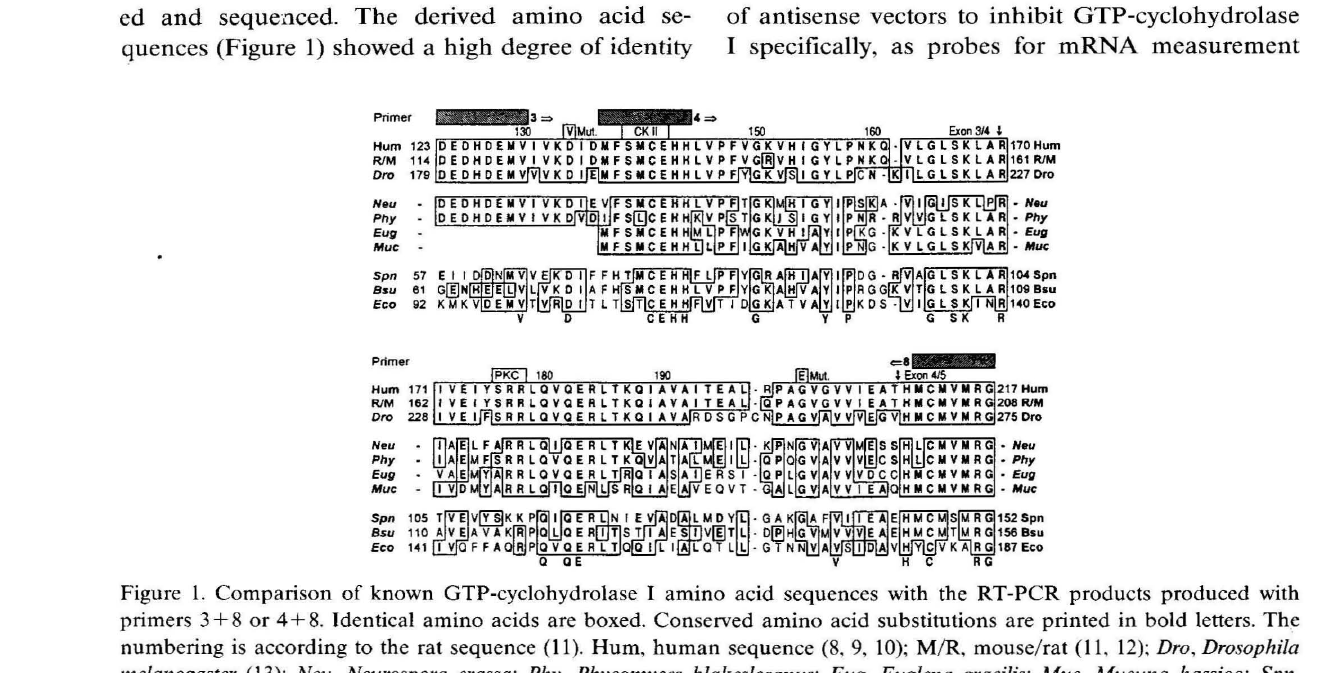
Pteridines / Vol. 6 /